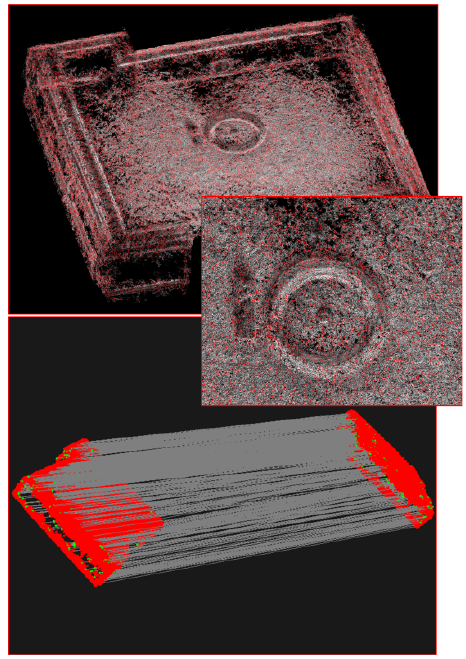
Figure 8. Keypoints extracted from Scenario A (top, red points) and outlier-free matches (green points) detected between Scenario A and B. Grey rays represent the vectors linking the points matched between the two point clouds.